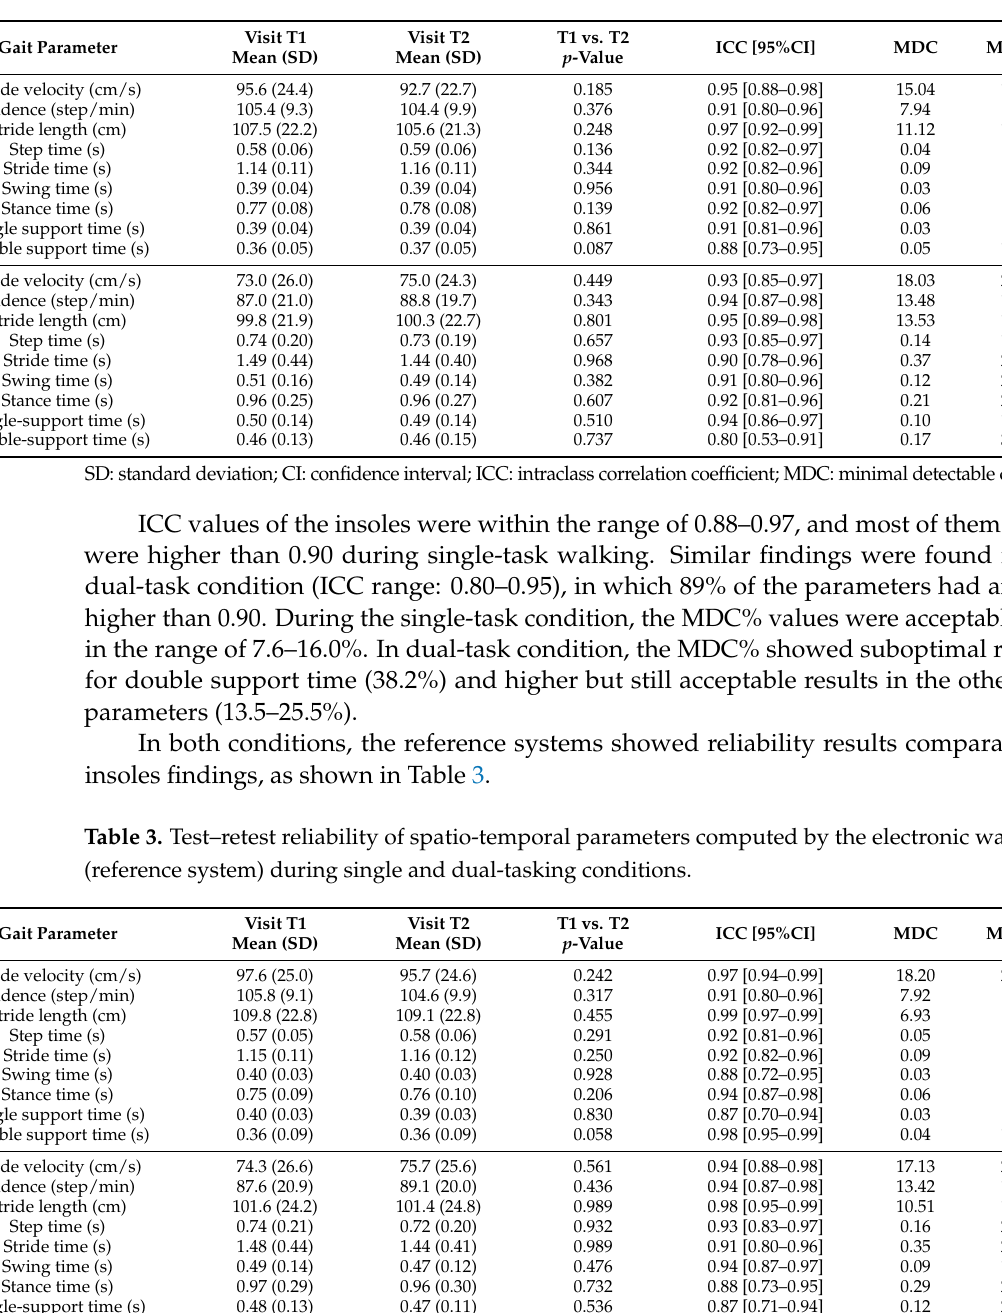
Table 2. Test–retest reliability of spatio-temporal parameters computed by pressure-sensing insoles during single and dual-tasking conditions.